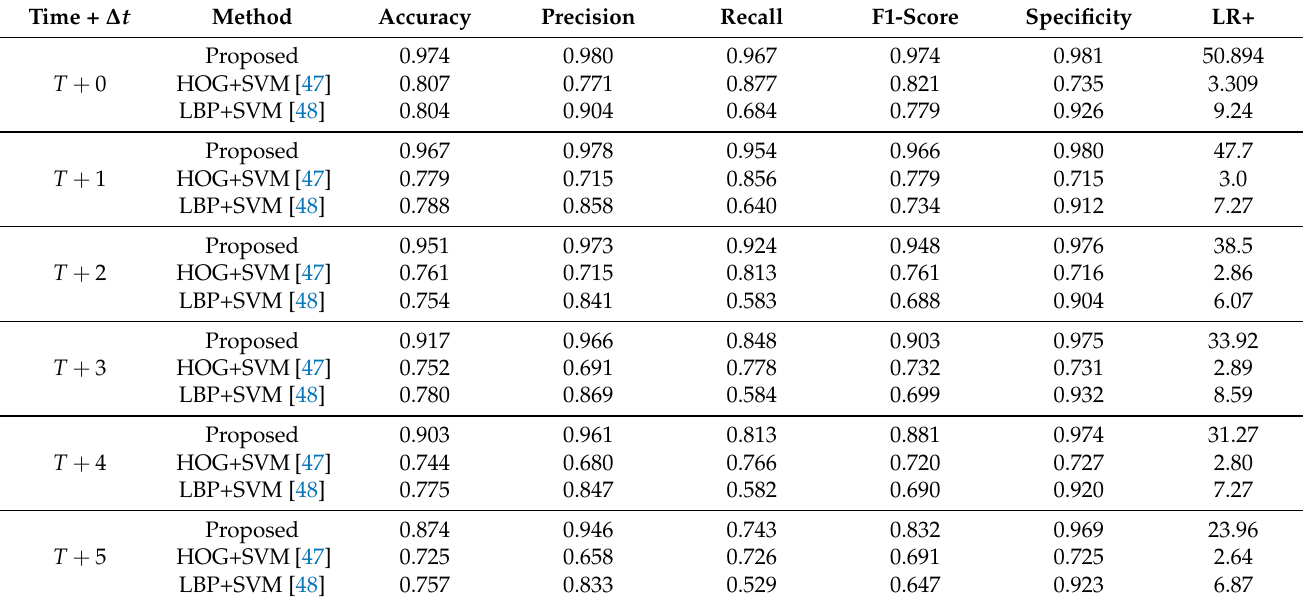
Table 1. Fish recognition performance vs. temporal distance in NINA204 test dataset. Each fish was compared with frames containing the same fish taken at different time step ∆ t (frames).